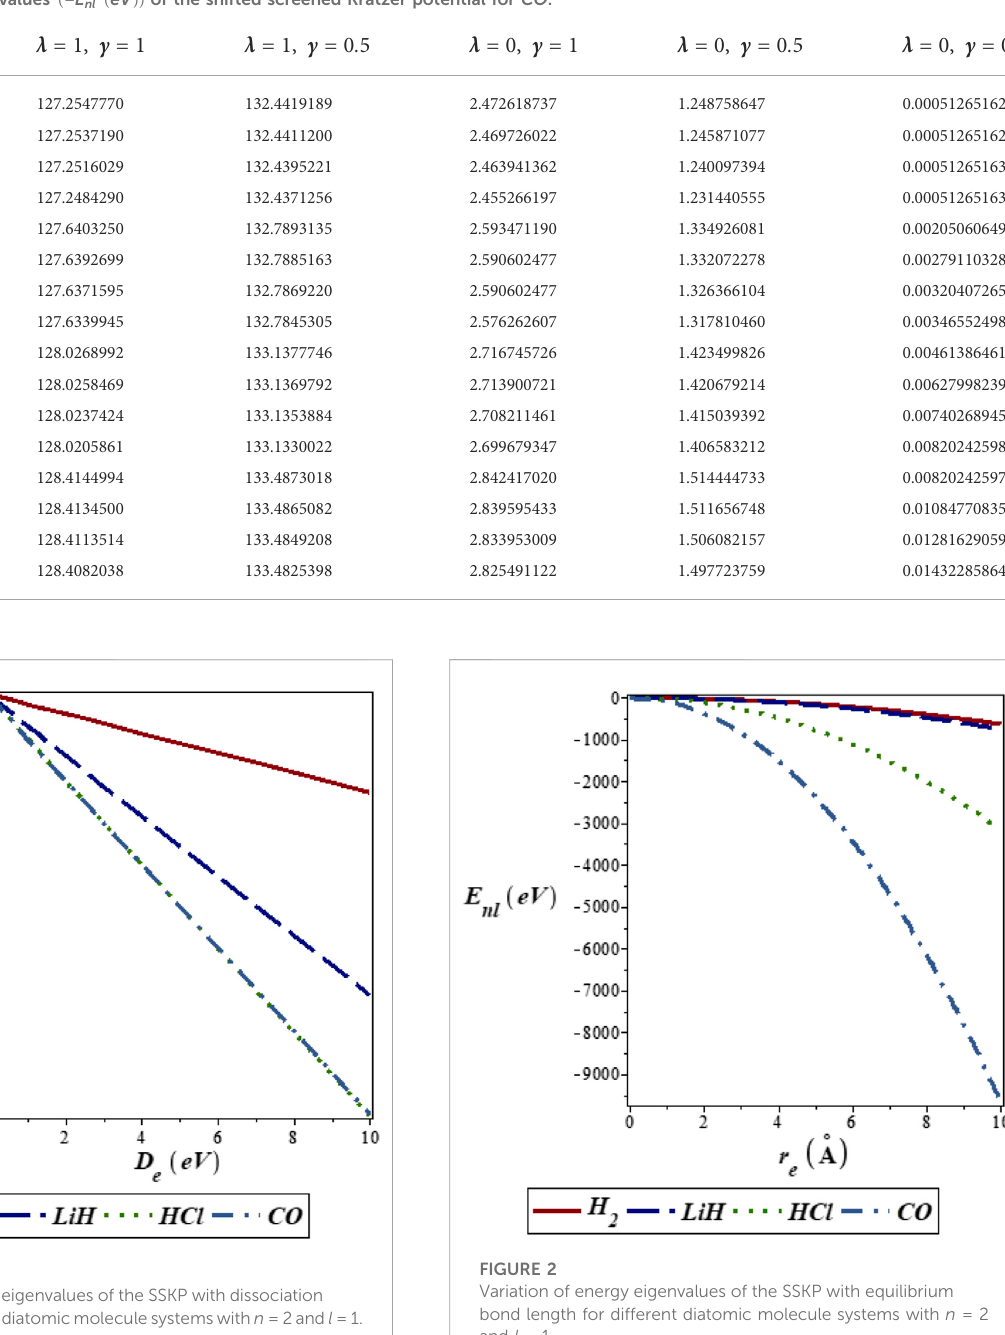
TABLE 5 Energy eigenvalues (− E nl ( eV )) of the shifted screened Kratzer potential for CO .